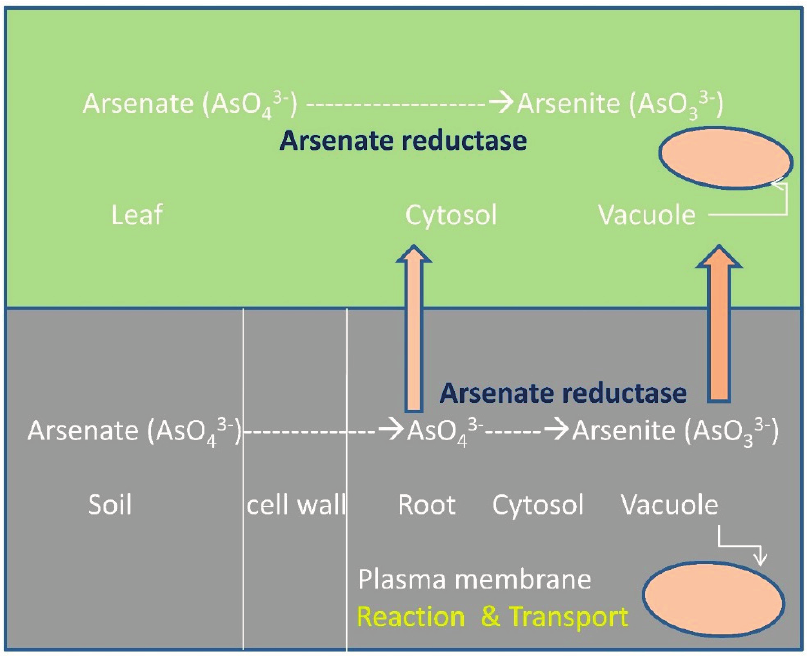
Figure 3. Mechanism of arsenic phytoremediation (modified from